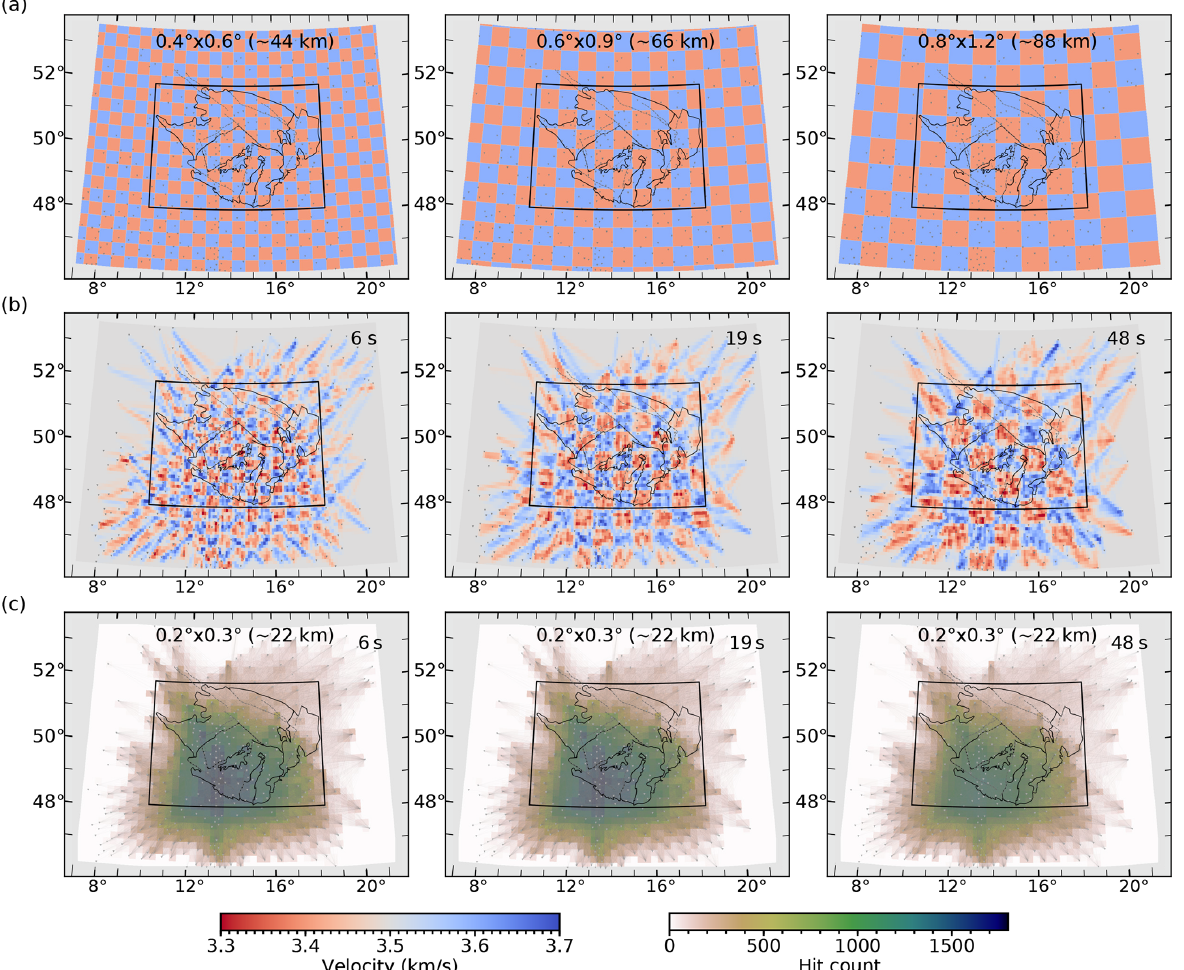
Figure 10. Checkerboard tests (b) calculated for models with cell sizes of 0.4 ◦ N–S by 0.6 ◦ E–W, 0.6 ◦ N–S by 0.9 ◦ E–W, and 0.8 ◦ N–S by 1.2 ◦ E–W (a) for ray-path coverages at periods of 6, 19, and 48s. The level of Gaussian noise added to the synthetic travel times corresponds to 50% of velocity variations in the synthetic velocity models (a) . (c) Hit counts express the numbers of rays crossing each cell centred around a 1-D inversion grid of 0.2 ◦ N–S by 0.3 ◦ E–W .